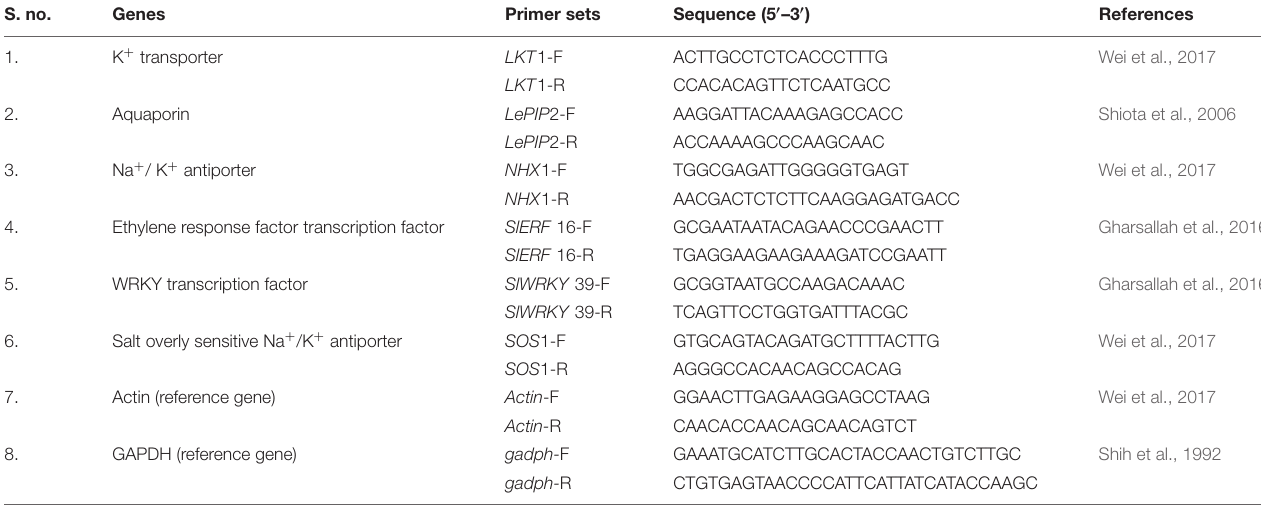
TABLE 1 | List of RT-qPCR primers used in the gene expression analysis. S. no. Genes Primer sets Sequence (5 (cid:48) –3 (cid:48)